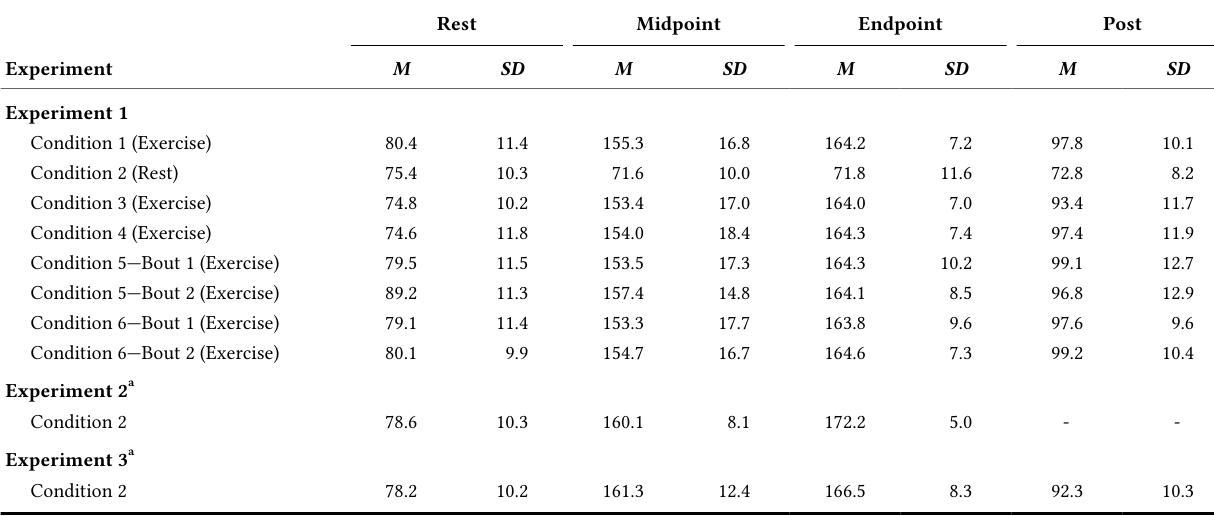
Physiological (Heart Rate) Responses to the Exercise and Rest Conditions Across the Three Experiments